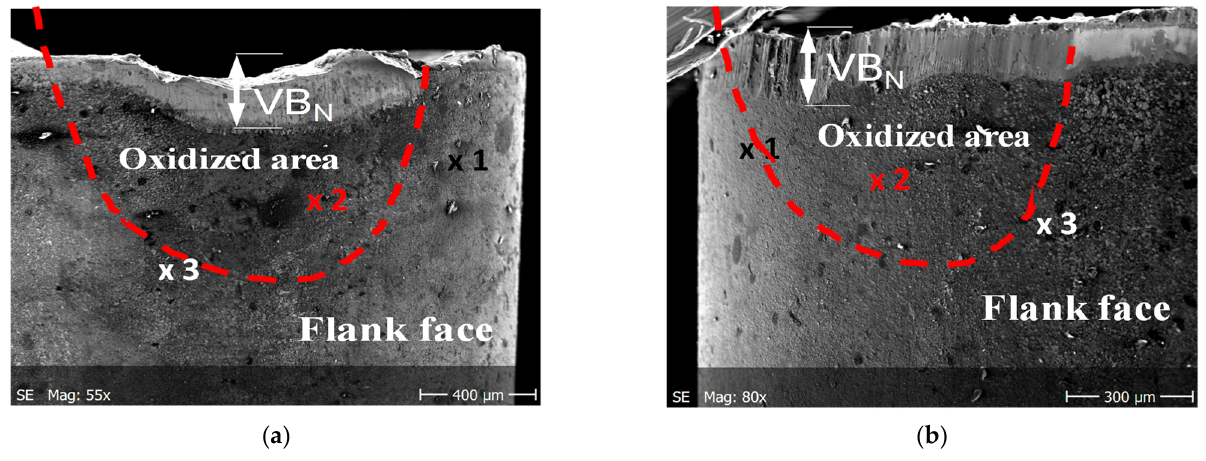
Figure 10. SEM images of flank faces obtained after machining of IN718 ( a ) and Ti6Al4V ( b ) workpieces with the cutting speed of 200 m/min; machining time of 2 min.